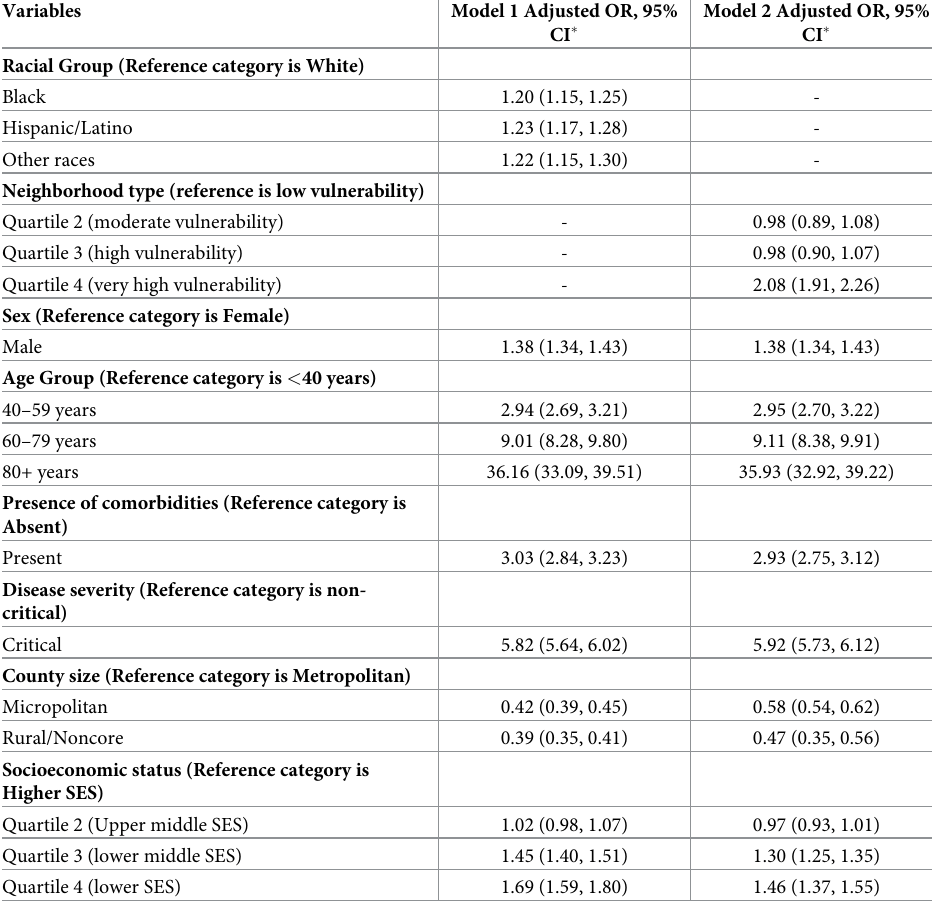
Table 3. Results of the fully adjusted multivariable logistic regression